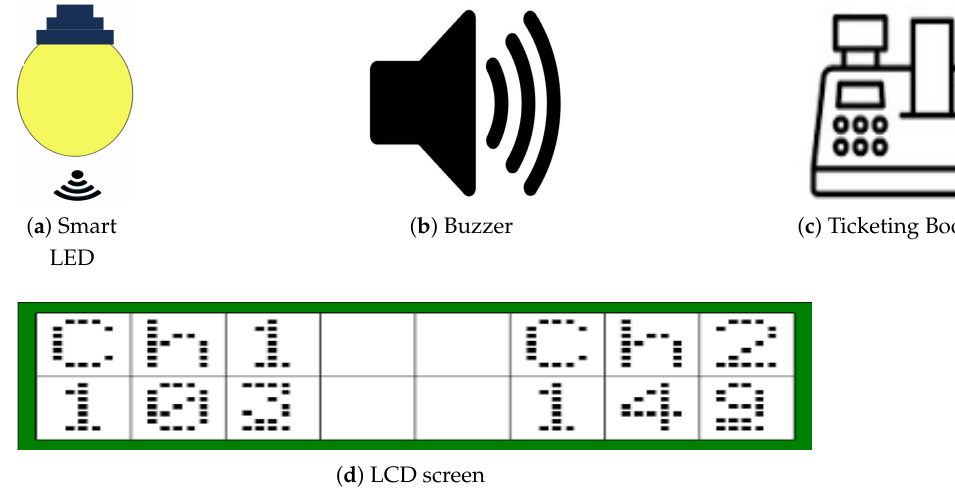
Figure 2. Examples of on-site data consumers. ( a ) Smart bulb. ( b ) Buzzer for alarm. ( c ) Ticketing booth. ( d ) Display screen.